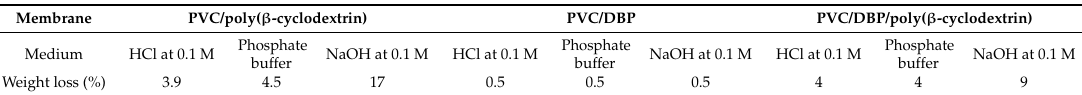
Table 2. Influence of wastewater pH on the stability of different polymer inclusion